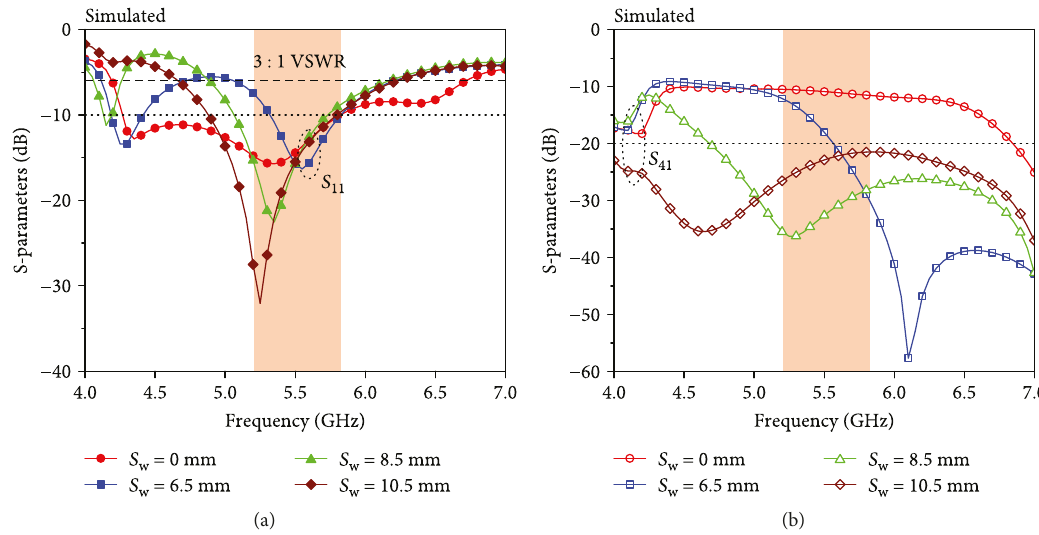
Figure 5: Simulated S-parameters of the antenna with the slit in the system ground: (a) S 11 and (b) S